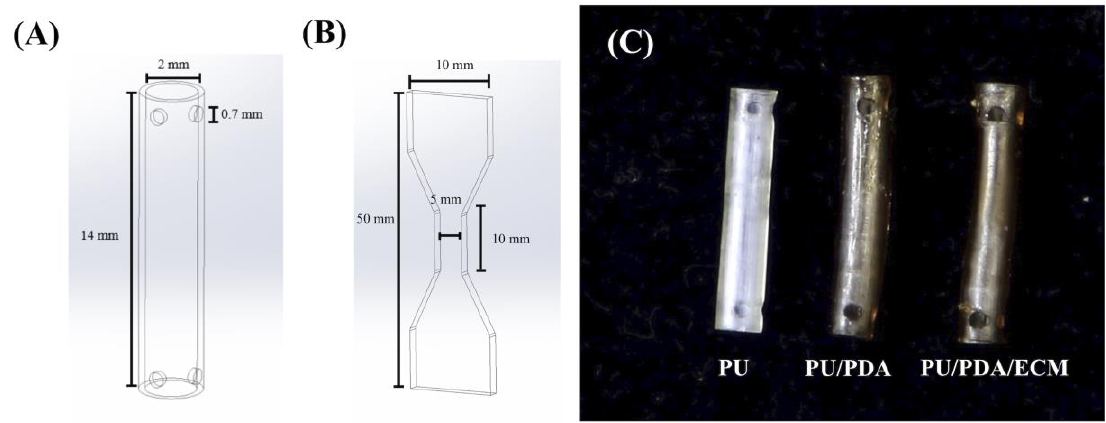
Figure 1. Schematic drawing of ( A ) the conduit and ( B ) the dumbbell-shaped sample used in the mechanical testing. ( C ) The top-view photograph of 3D-printed PU-based conduits. PU, polyurethane; PDA, polydopamine; ECM, extracellular matrix.